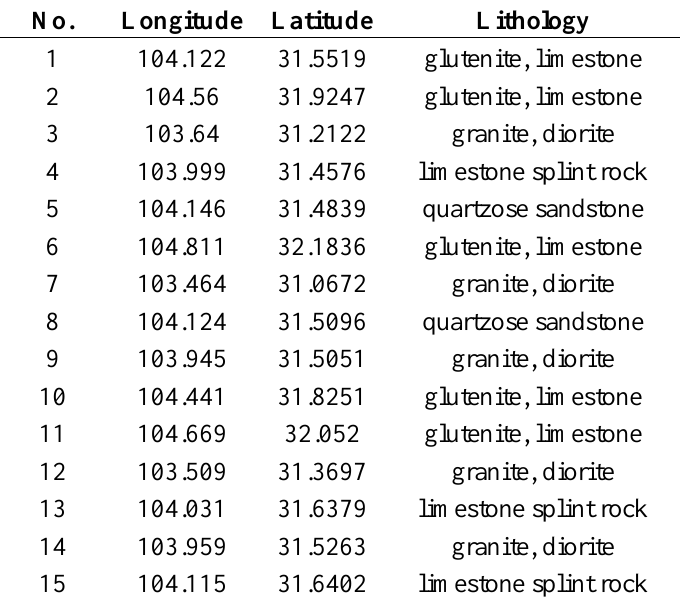
Table 6. Lithology of the selected hazards